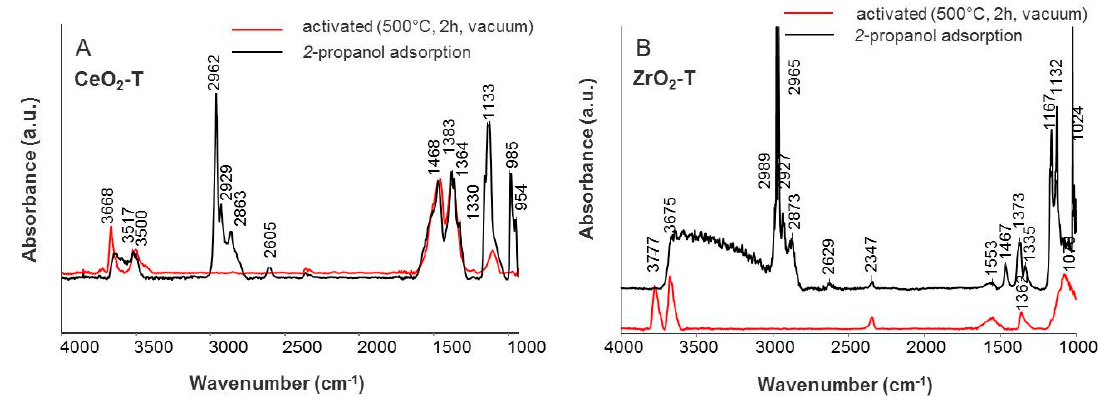
Figure 7. IR spectra of adsorbed iso -propanol on CeO 2 -T ( A ) and ZrO 2 -T ( B ).